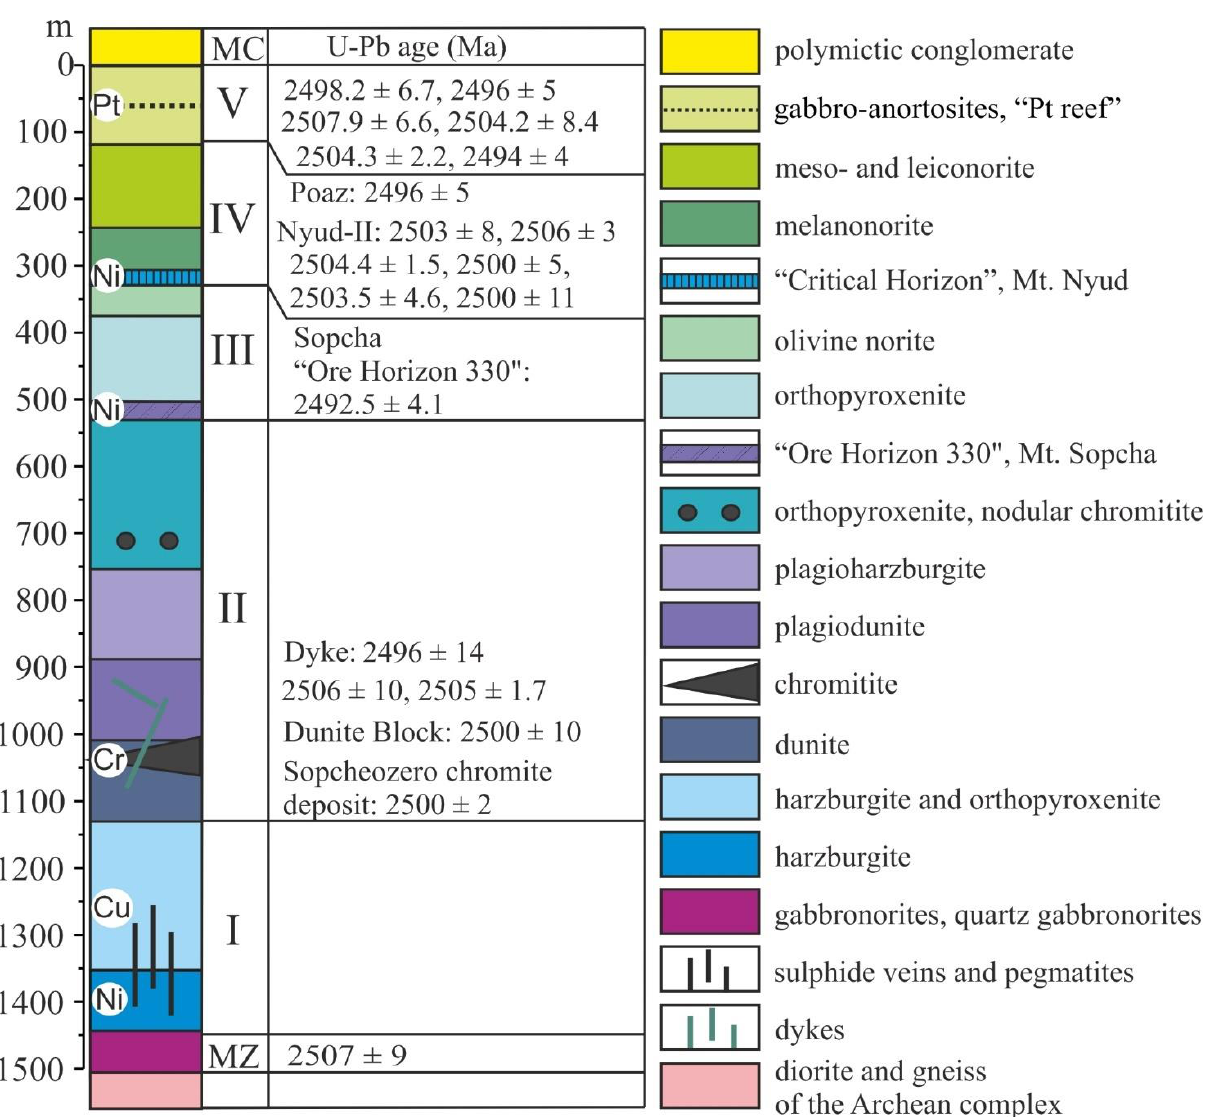
Figure 3. Generalized cross-section of the Monchepluton showing its formation in terms of megacycles.